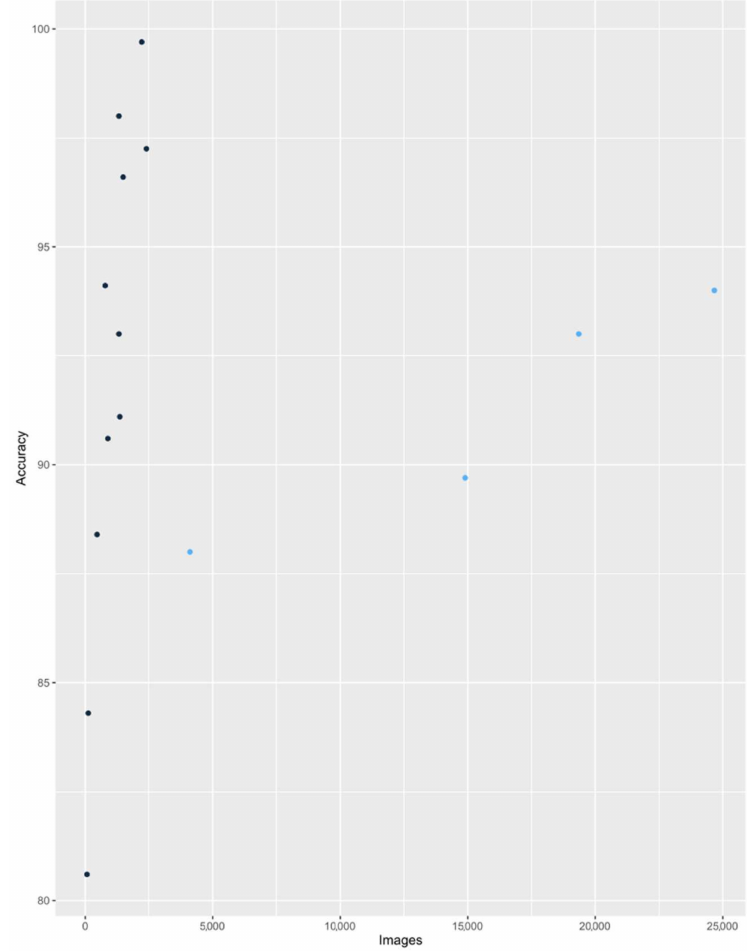
Figure 3. Dot plot of the accuracy of included studies (there are more dots than studies because some research analyzed more than one classification of laryngeal lesions). The dark blue points represent the group of studies for which the linear regression equation was calculated. The remaining studies are marked with light blue